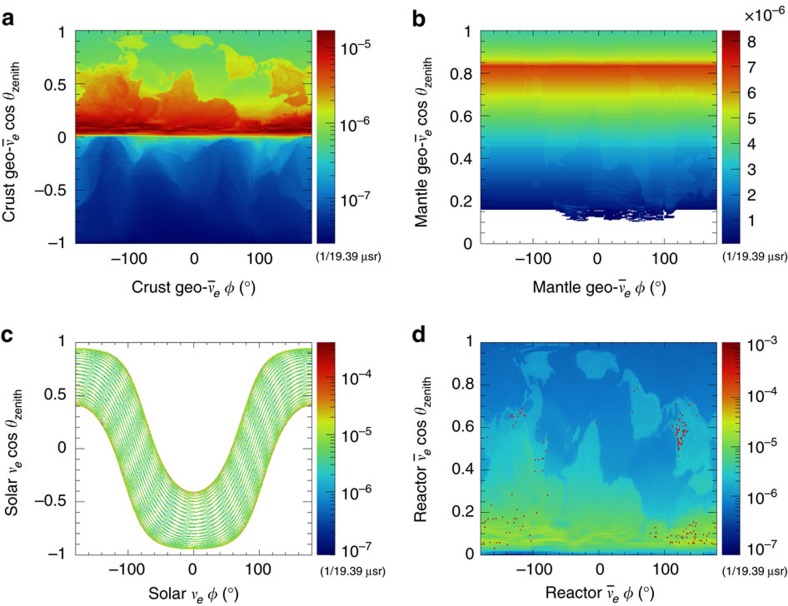
Angular distribution of incident neutrinos at Gran Sasso.Angular distributions calculated at Gran Sasso (Italy) and shown here for incident neutrinos from: (a) the Earth’s crust; (b) the Earth’s mantle; (c) the Sun; and (d) worldwide nuclear power reactors. The azimuthal angle ϕ is measured clockwise from due North, while the zenith angle θzenith is measured with respect to the vertical axis, defined opposite the direction pointing to the centre of the Earth. (a,b) Crust and mantle geo-neutrino distributions are derived using CRUST 1.0 (ref. 15) and PREM16, supplemented with detailed topological information for cos θzenith<0. (c) The solar neutrino distribution is integrated over 1 calendar year at a latitude of 42.45°. (d) The directions to nuclear power reactors22 are shown here in red, superimposed on the crust geo-neutrino map for visualization. The cluster at ϕ=120°, 0.5<cos θzenith<0.6 is due to nuclear power reactors in the eastern half of the United States, while the cluster at 100°<ϕ<180°, 0.05<cos θzenith<0.15, and continuing to −180°<ϕ <−100°, is due to nuclear power reactors in Western Europe, particularly France. Nuclear power reactors in South America, South Africa, Japan and India are also visible here. All plots are normalized to unit volume.